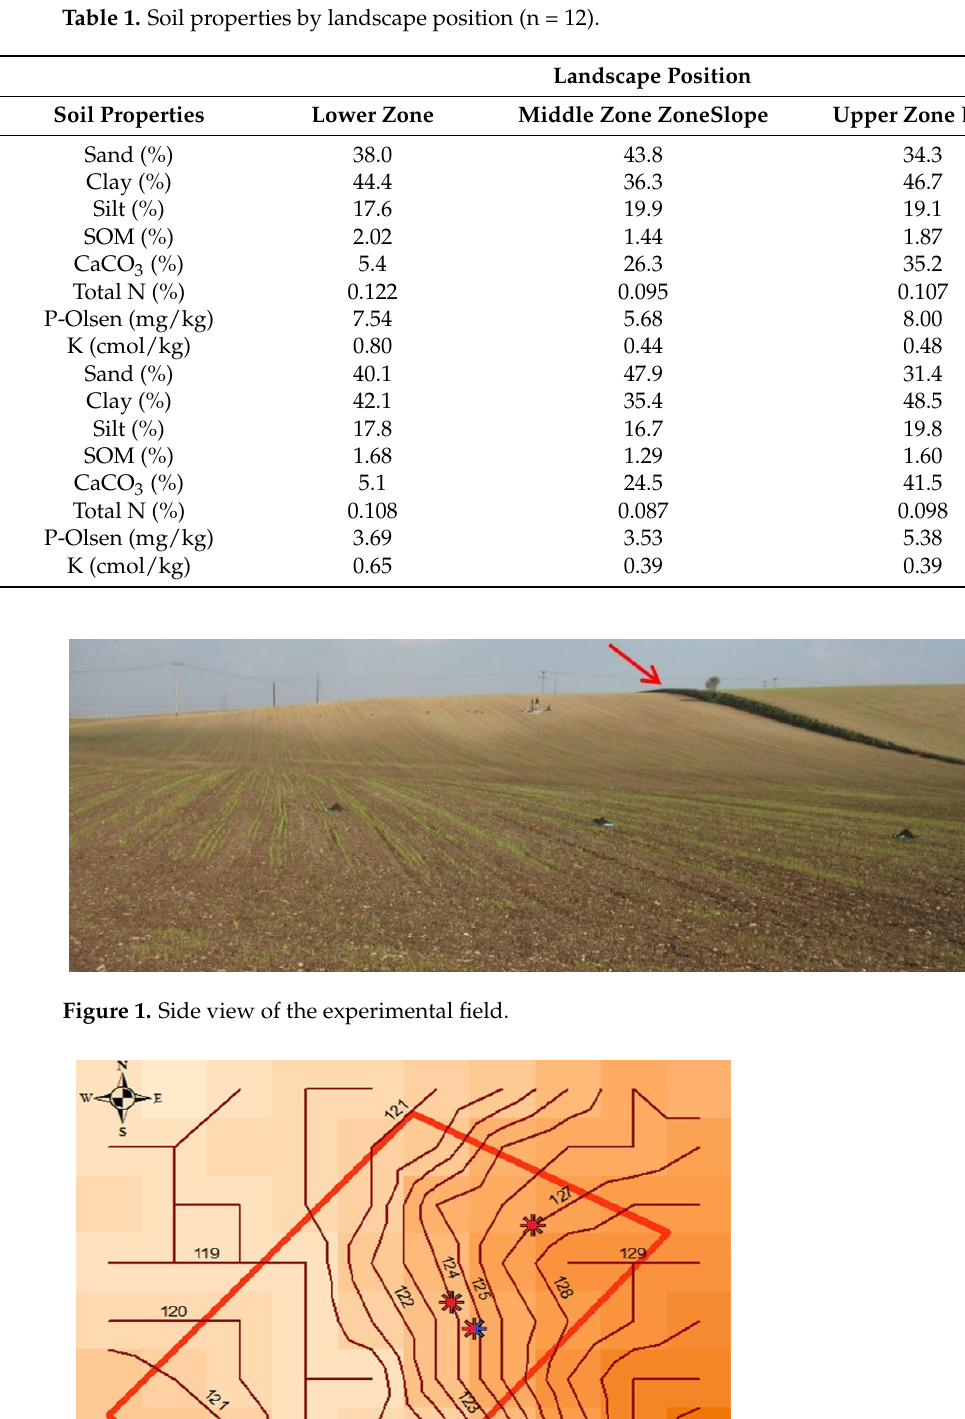
Table 1. Soil properties by landscape position (n = 12).